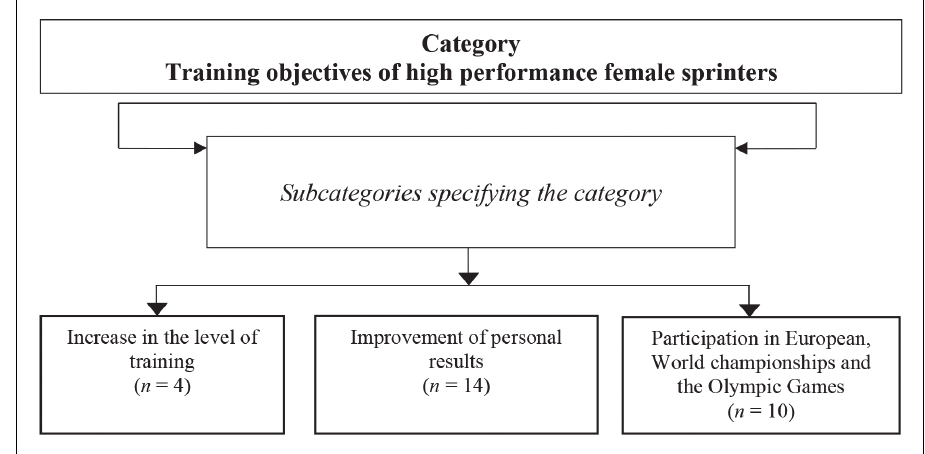
Figure 1. Principal